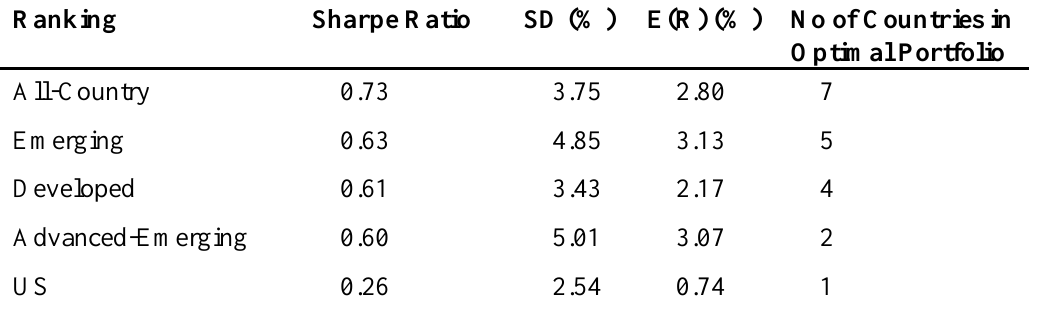
Table 3. Ranking of Optimal Portfolios by Sharpe